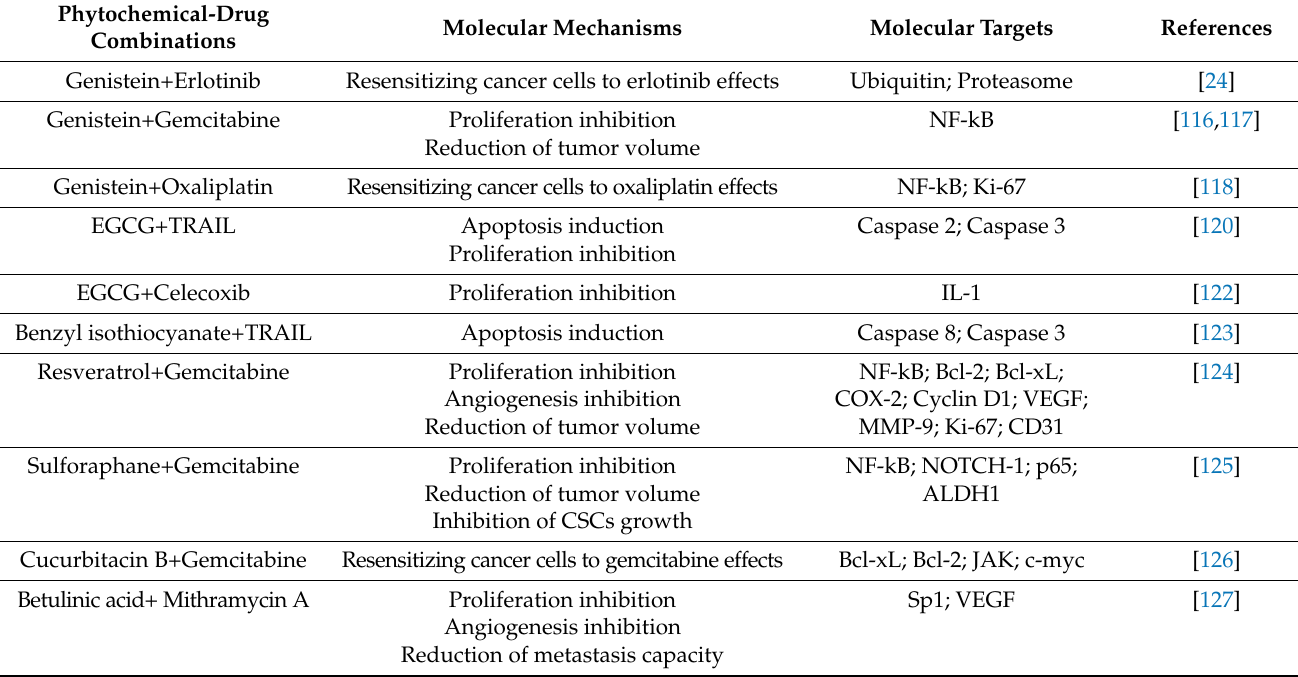
Table 4. Pancreatic cancer